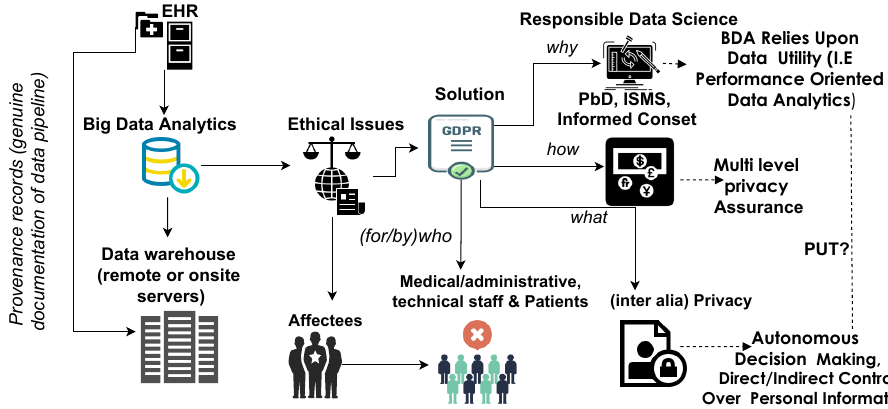
Figure 1. Description of the Problem